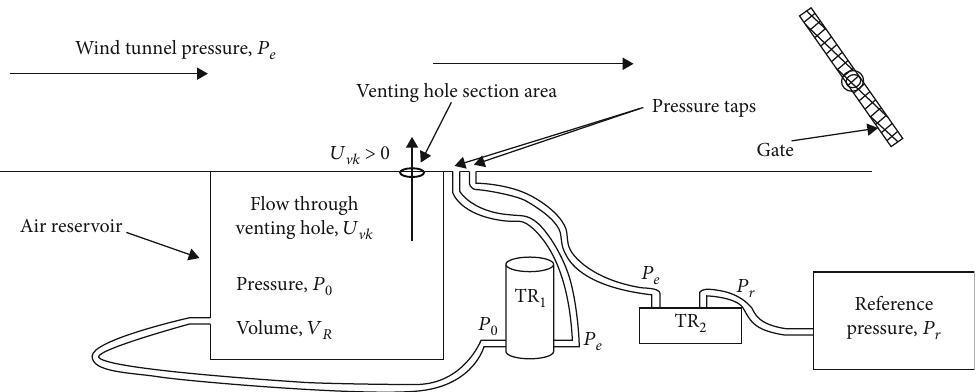
Figure 1: Schematic diagram of the experimental setup.